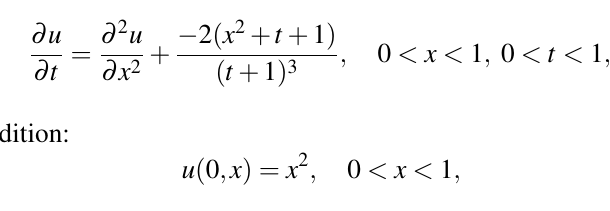
Table 3. L ∞ of Test Problem 4 for different numbers of collocation points